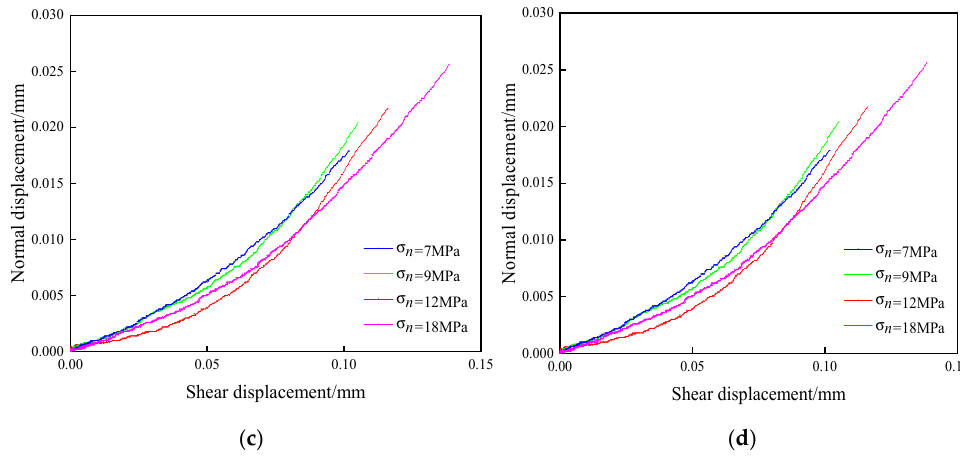
Figure 10. Normal displacement versus shear displacement curves of rock fractures under different lateral stresses: ( a ) σ c = 0 MPa; ( b ) σ c = 2 Mpa; ( c ) σ c = 7 Mpa; ( d ) σ c = 10 Mpa.